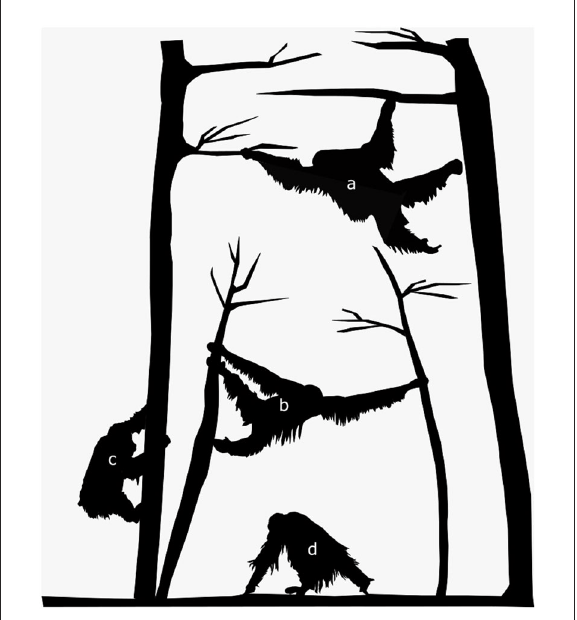
FIGURE3 Orangutan performs different locomotion types throughout the simulation, depending on the connectivity of trees. Here, we illustrate orangutan’s brachiation (a) through connected canopies, sway (b) by bending a tree to reach another in proximity, tree climbing (c) from the forest floor, and terrestrial walk (d). Illustration by